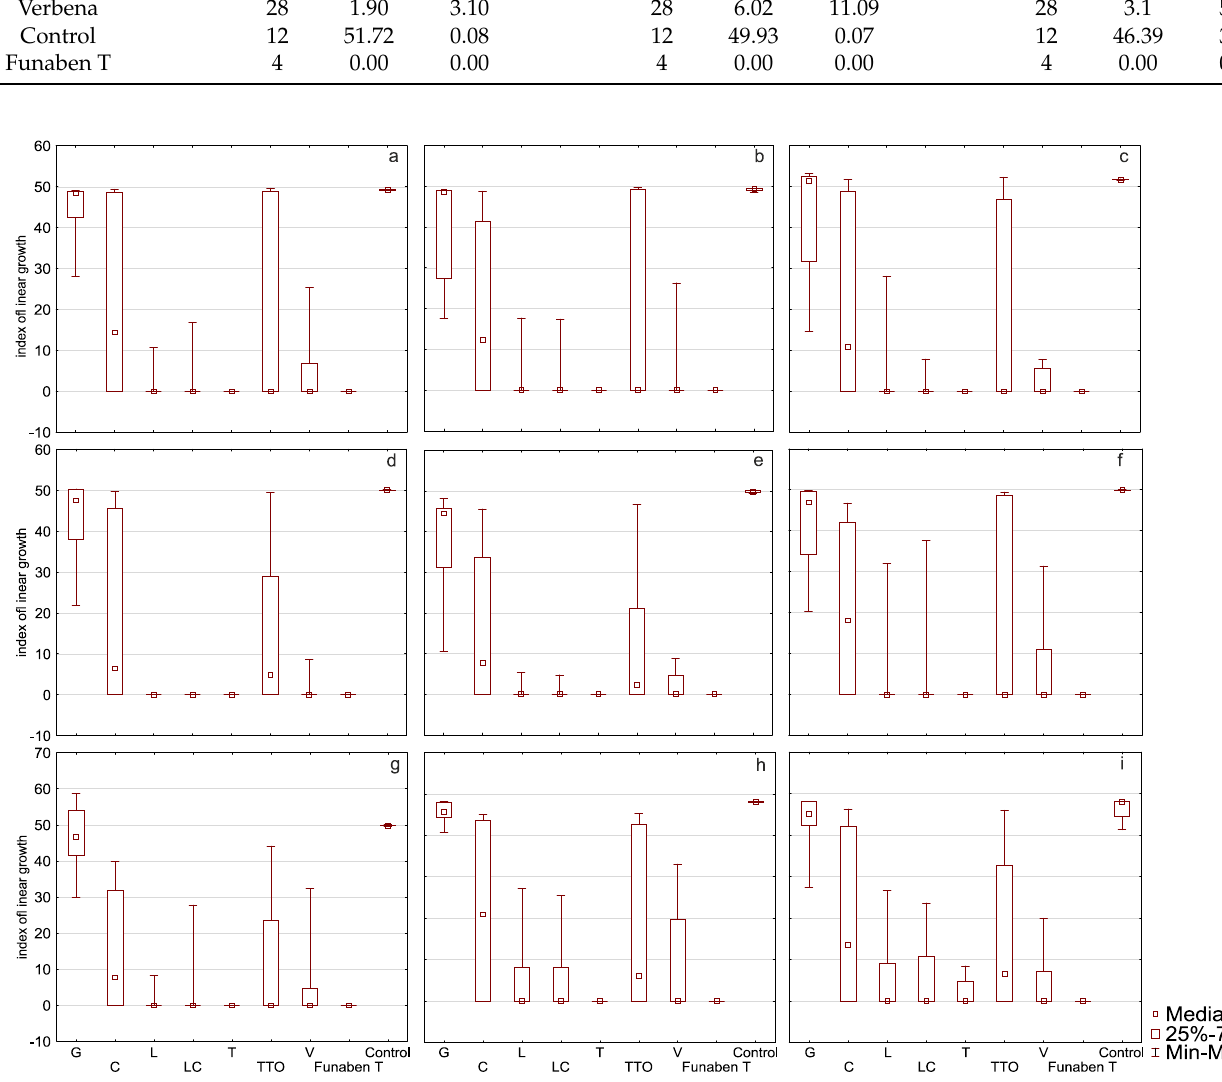
Figure 4. Indexes of linear growth (T) of Fusarium ssp. isolates for all concentration of EsO together (D-Germany, PL-Poland): ( a ) FC2D— F. culmorum , ( b ) FG2D— F. graminearum , ( c ) FG1D— F. graminearum , ( d ) FC1D— F. culmorum , ( e ) FCPL—F. culmorum , ( f ) FP0D— F. poae , ( g ) FGPL— F. graminearum , ( h ) FAPL— F. avenaceum , ( i ) FOPL— F. oxysporum ; index